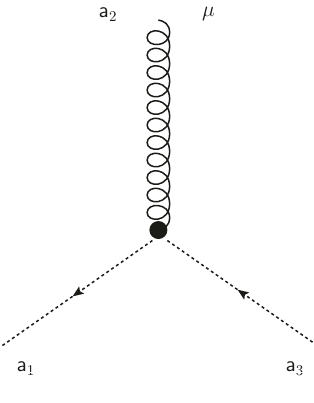
Figure 3 . The ghost